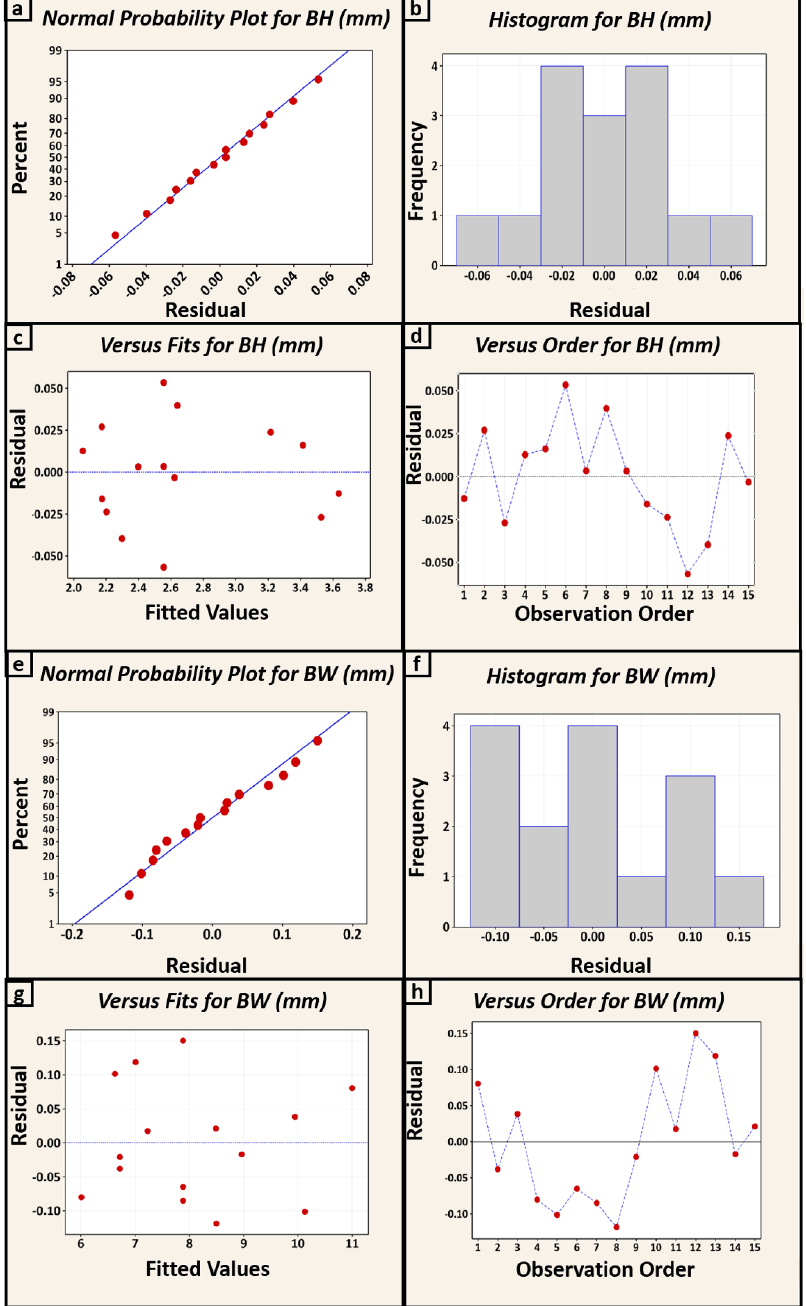
Figure 8. The different residual plots include ( a , e ) normal probability plot, ( b , f ) histogram plot, Ver− sus fit ( c , g ), and versus order ( d , h ) of both BH and BW developed using the RSM approach.